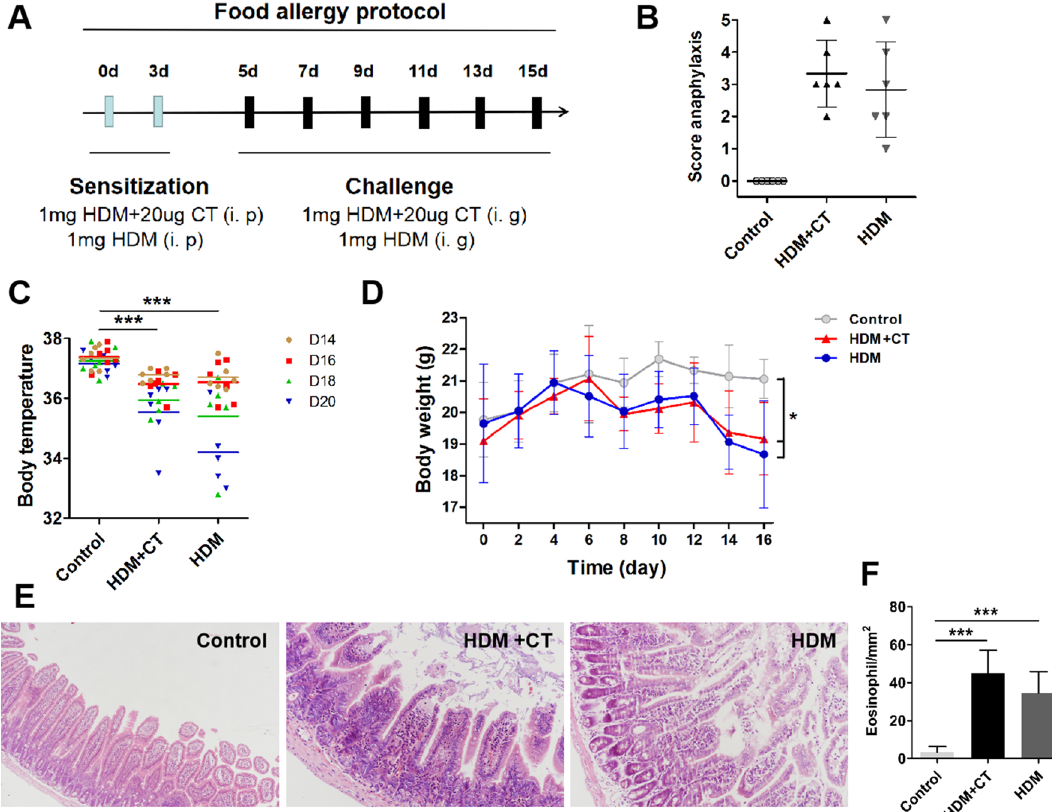
Figure 2. Establishment of a mouse model of food allergy with HDM. ( A ) The protocol for mouse model of HDM-induce food allergy. ( B ) the score of allergies of mouse. no symptoms, 0; scratch, scratch head and nose, 1; eye and mouth swelling, diarrhea, reduced activity and/or reduced activity with breathing emergency urge, 2; asthma, slow breathing, mouth and tail cyanosis, 3; After stimulate or shake, there is no activity, 4; death, 5. ( C ) the body temperature of mouse. ( D ) body weight of mouse. HE staining of jejunum. ( F ) the number of eosinophils in jejunum. Each group consists of 6 mice.* p < 0.05, ** p < 0.01, *** p < 0.001, (ANOVA) compared to the control group. One mouse died in the HDM group on day